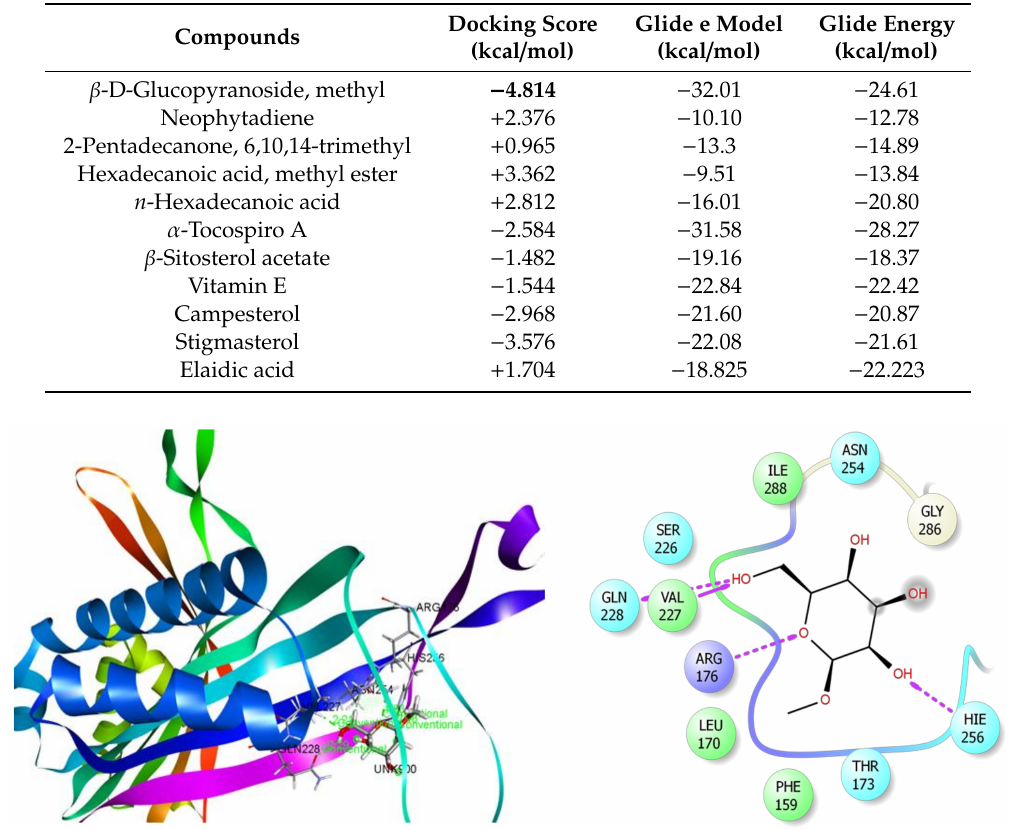
Figure 11. Best ranked poses and 2D interactions of β -D-Glucopyranoside, methyl with xanthine oxidoreductase (pdb: 1R4U) for antioxidant